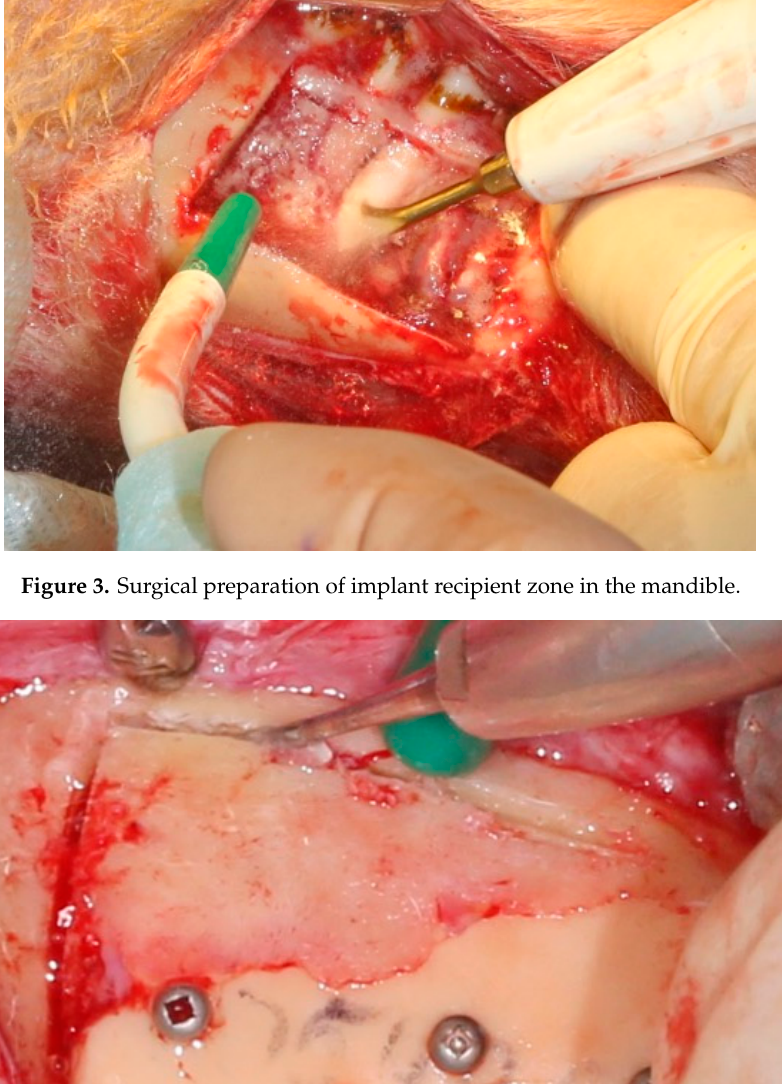
Figure 3. Surgical preparation of implant recipient zone in the mandible.